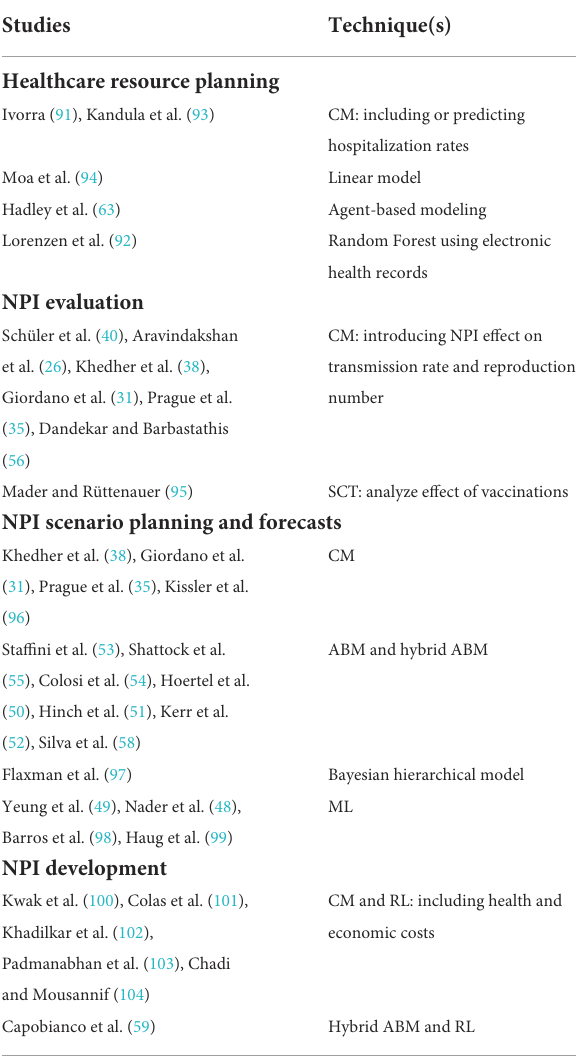
TABLE 7 Included studies covering decision